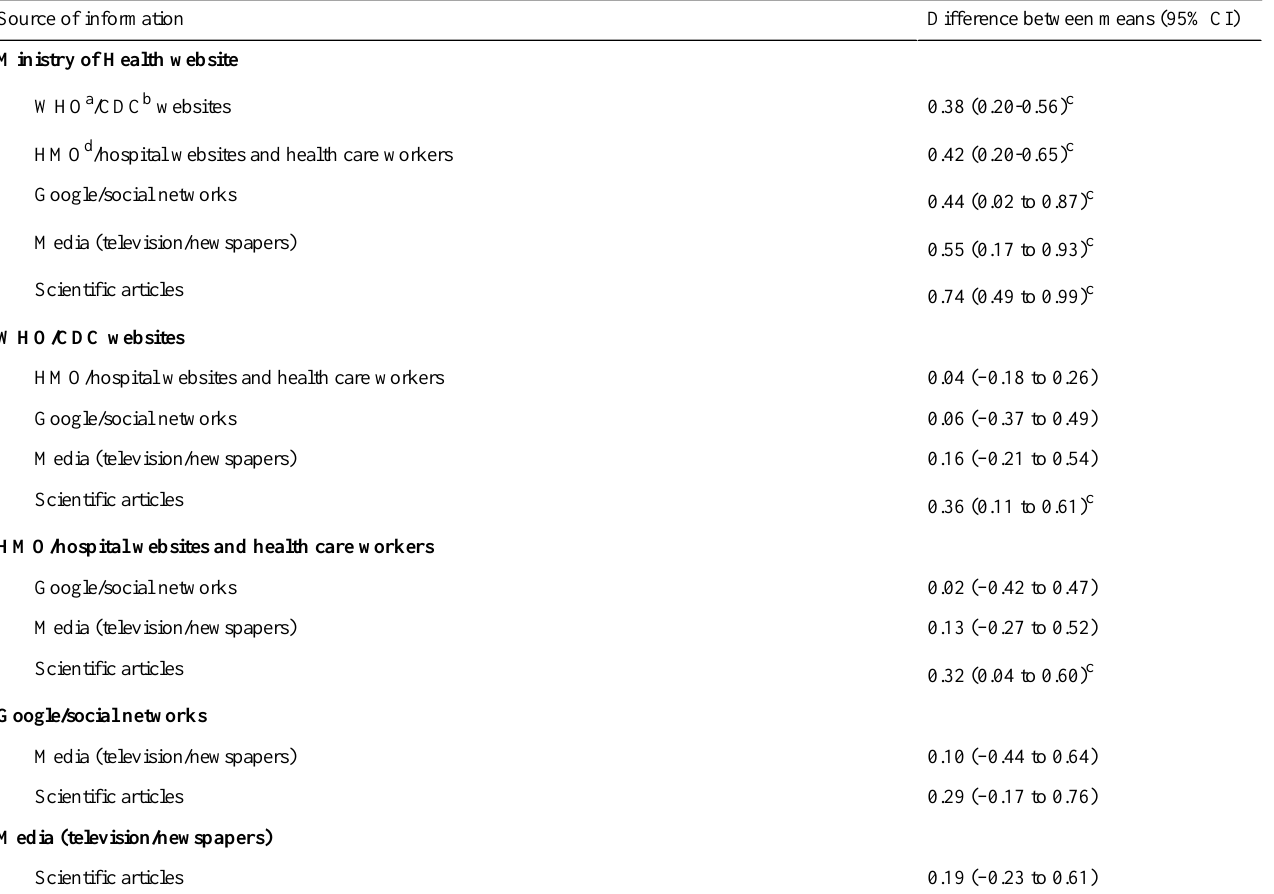
Table 7. Results of the Tukey HSD test for difference between most credible source of information and the attitudes toward crisis management